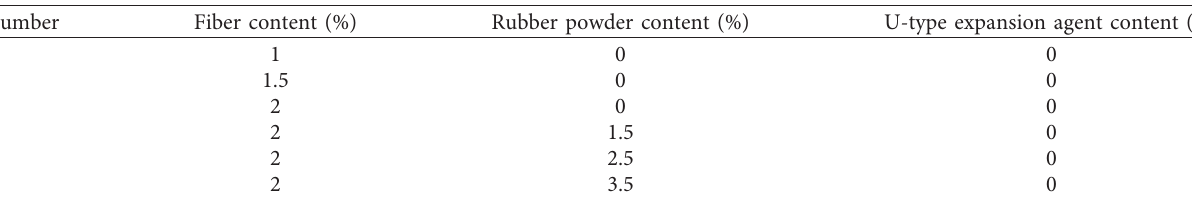
Table 2: Values of fiber, rubber powder, and expansion agent contents.